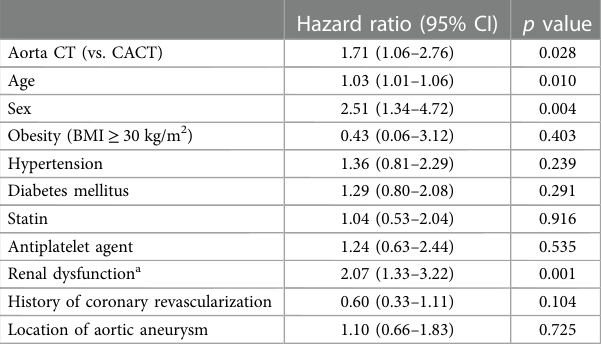
TABLE 2 Independent predictors for composite of all-cause death or myocardial infarction in patients with aortic Figure S3 ). Most